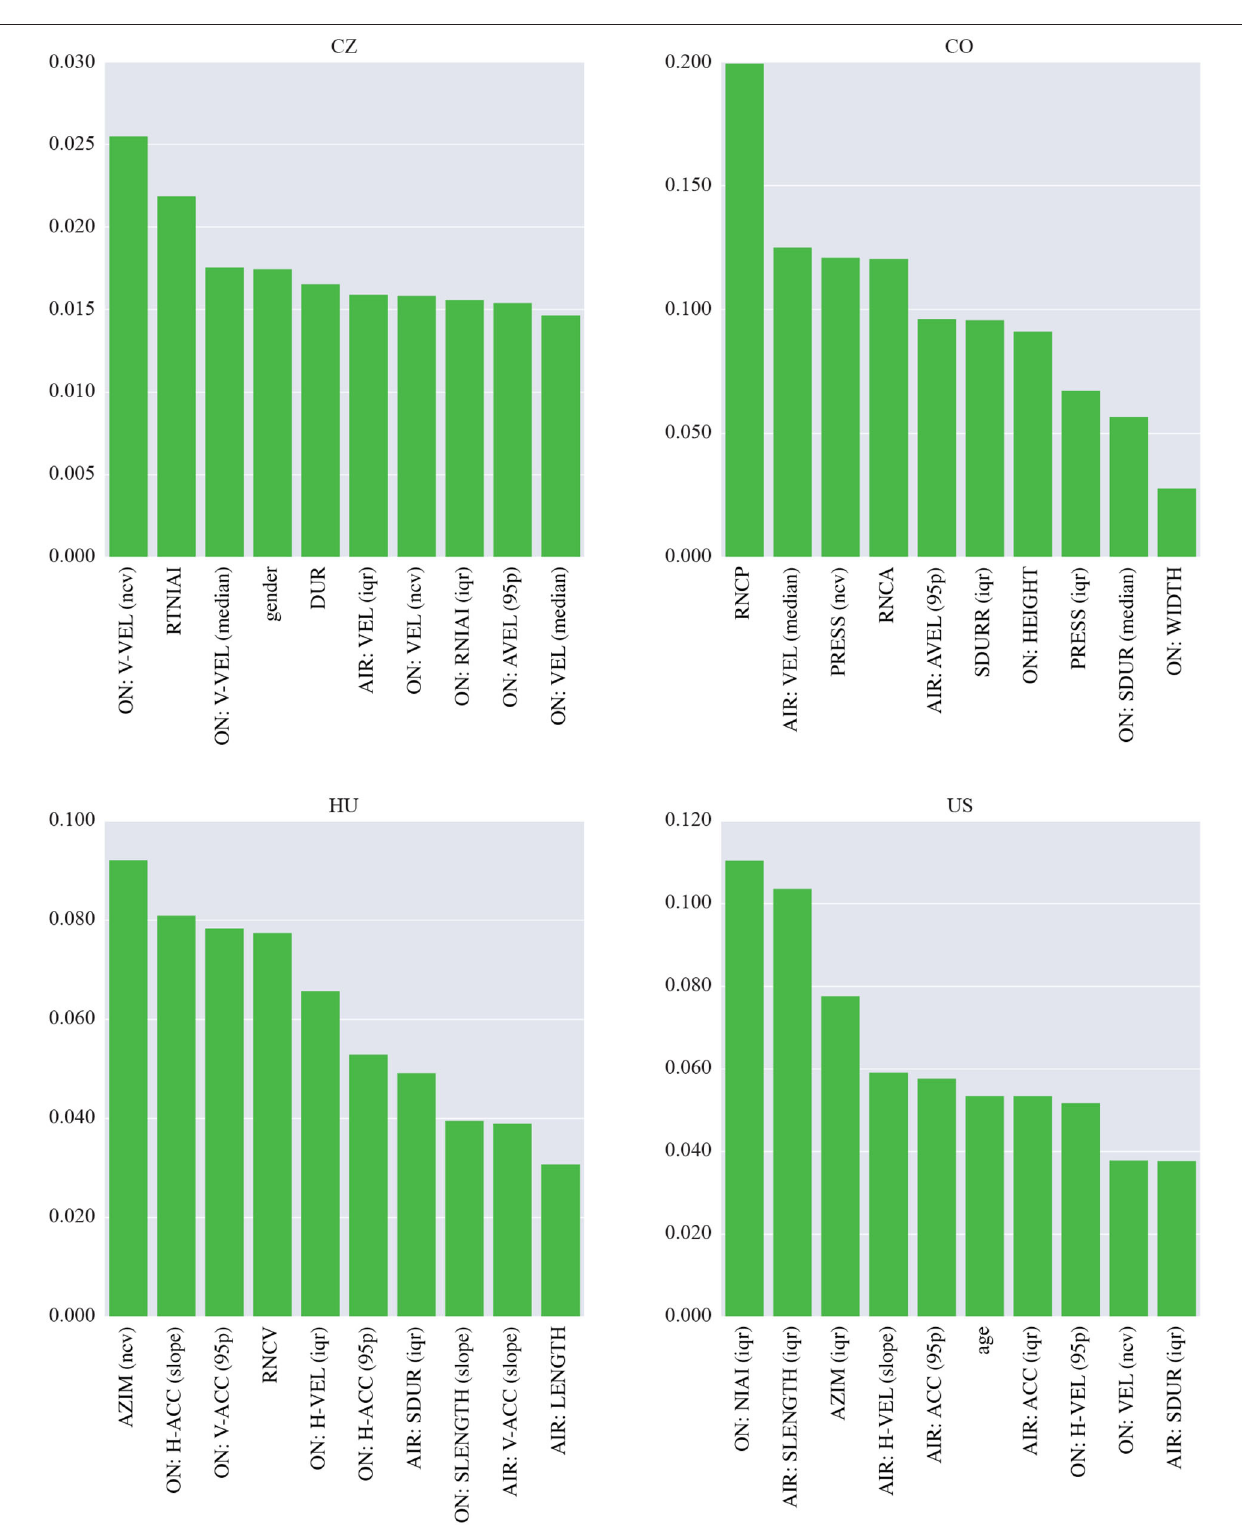
Frontiers in Neuroinformatics |